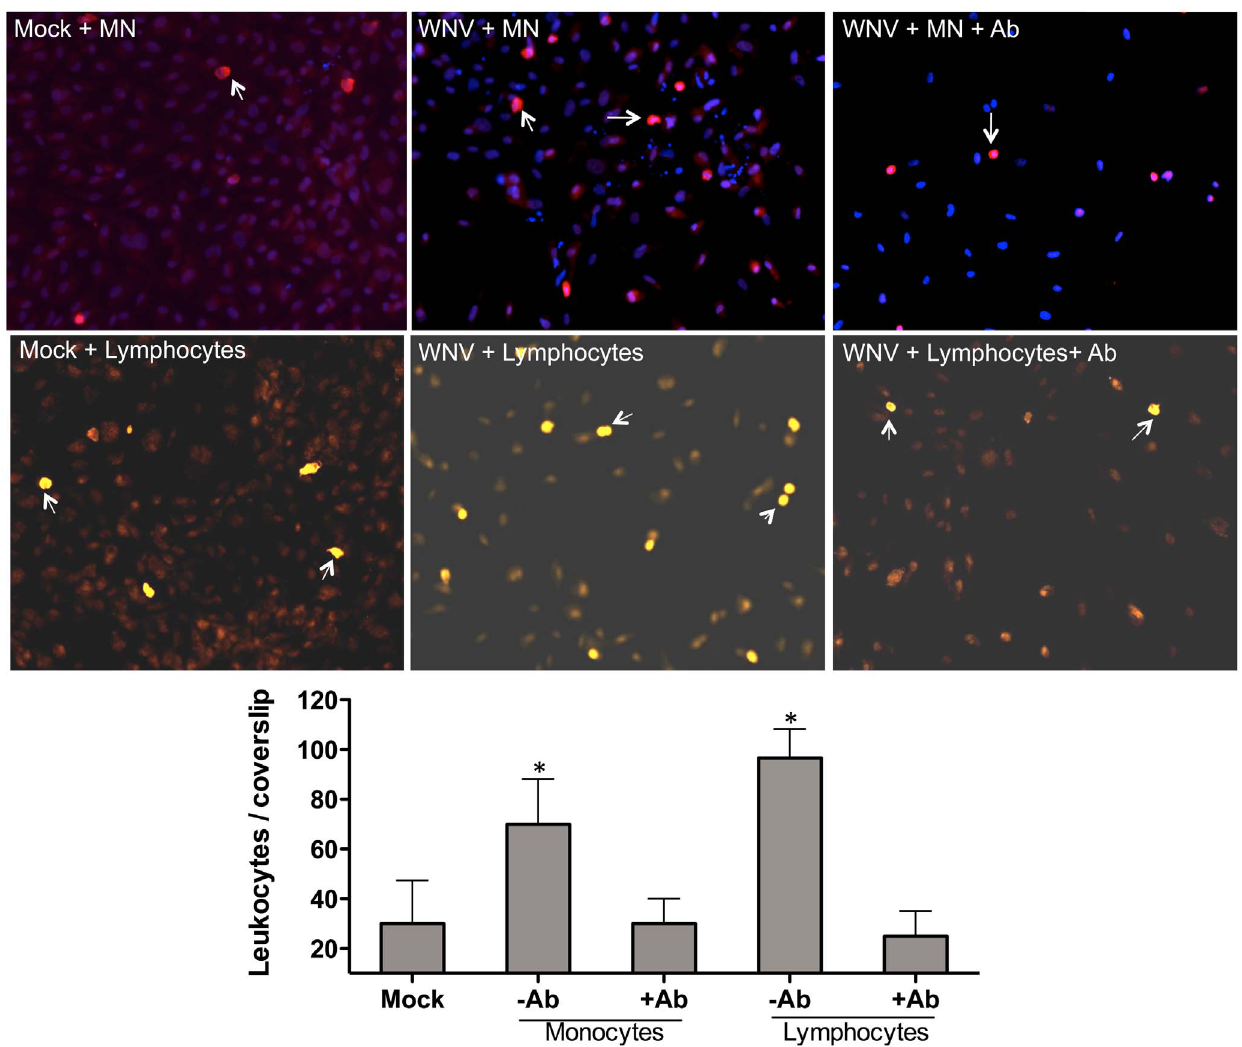
Figure 4. Blocking of cell adhesion molecules limits leukocyte adhesion to the HBMVE cells. HBMVE cell monolayers on the coverslips were infected with WNV for 72 hrs and then 2 x 10 5 monocytes or lymphocytes were added to the cells in the presence or absence of the cocktail of neutralizing antibodies against CAMs (ICAM-1, VCAM-1 and E-slectin). After two hrs, the non-adhered leukocytes were vigorously washed off and adherent cells were stained with CD45 (white arrows). ( A ) Immunofluorescence micrograph of CD45-stained monocytes and lymphocytes. ( B ) Quantitative representation of CD45 + cells from six different areas per coverslip from three independent experiments. *p , 0.05 compared to mock.